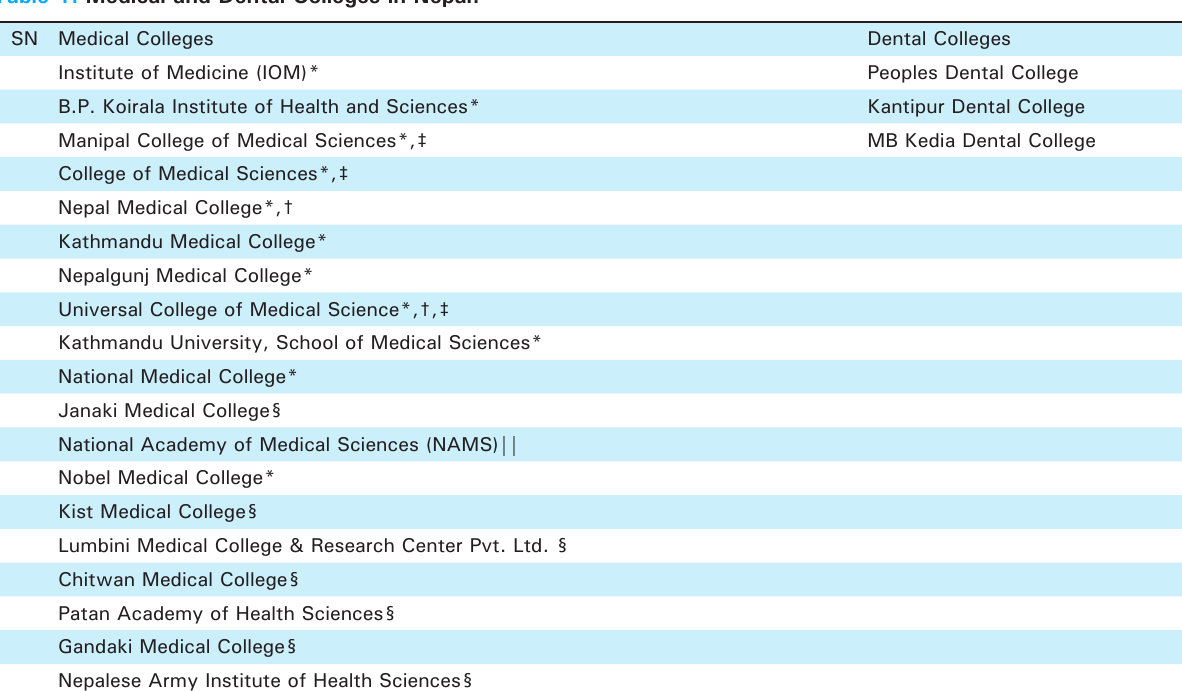
Table 1. Medical and Dental Colleges in Nepal.